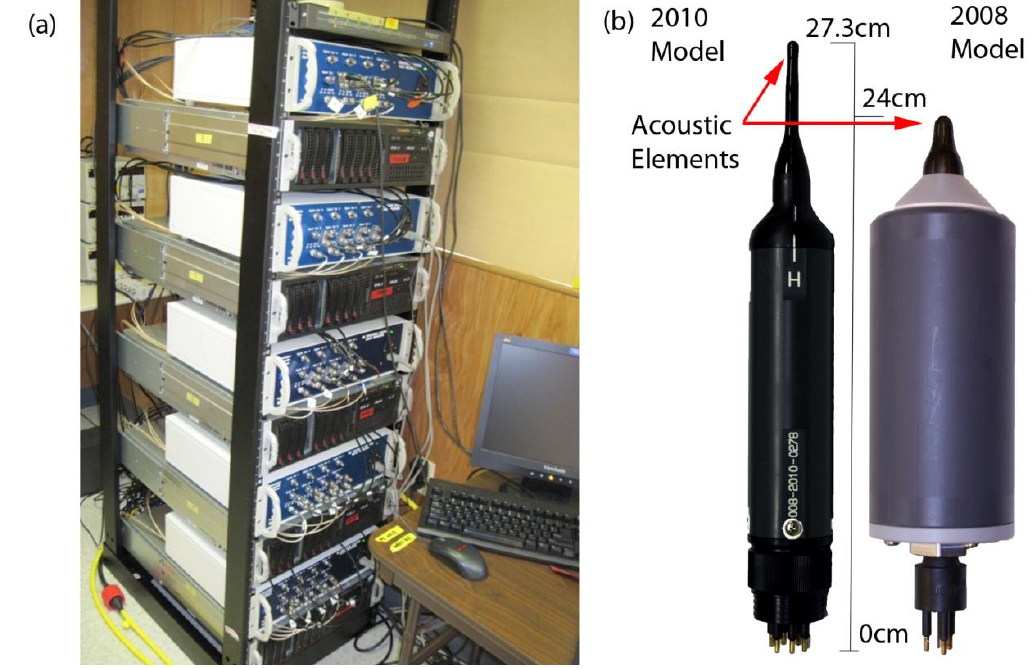
Figure 4. JSATS cabled system components: (a) data collection array; (b) cabled